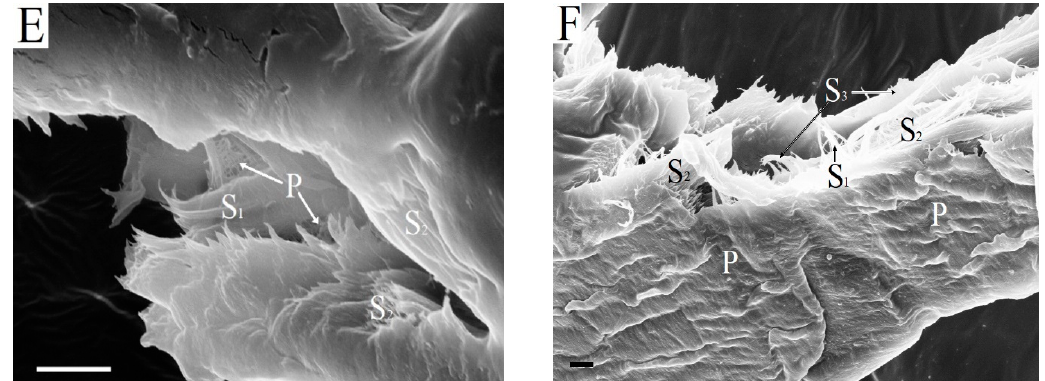
Figure 7. Kraft fibers at different stages of enzymatic degradation: ( A ) fiber of BSP with preserved primary wall; ( B ) cross-cutting of the BSP fiber after 1 h of enzymatic hydrolysis; ( C ) cross-cutting of the BSP fiber after 3 h of enzymatic hydrolysis; ( D ) the cellobiohydrolase catalyzes the hydrolysis of cellulose microfibrils of the S 2 layer; ( E ) primary wall fragments were preserved during enzymatic degradation of S 1 layer and S 2 layer; and, ( F ) enzymatic degradation of the surface of BHP fiber after 5 h of enzymatic hydrolysis. CM—cellulose microfibrils, P—primary wall, S 1 —S 1 layer, S 2 —S 2 layer. Bars: A—200 nm; B–F—1 μ m.